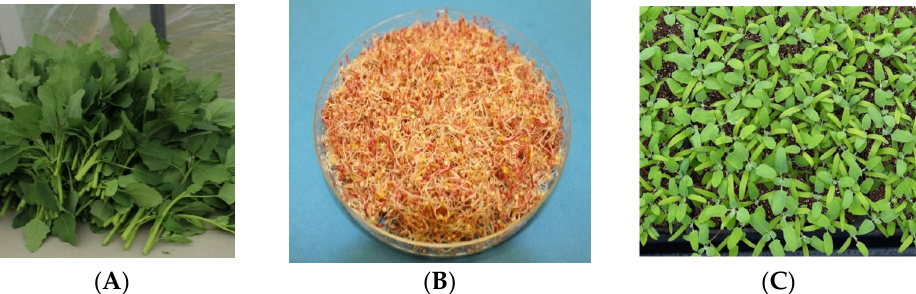
Figure 1. Representative pictures of quinoa greens, ( A ) green leaves, ( B ) sprouts, and ( C ) microgreens.